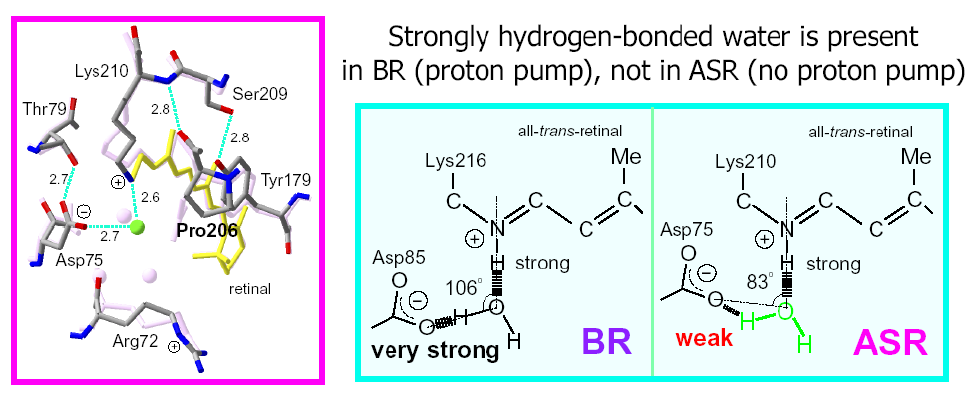
Figure 40. X-ray crystallographic structures of the Schiff base region of ASR and BR (Left). Schematic drawing of hydrogen bonds of the water molecule locating between the protonated Schiff base and its counterion (Right). This figure is reprinted with permission from TOC of Furutani et al [20]. Copyright 2005 American Chemical